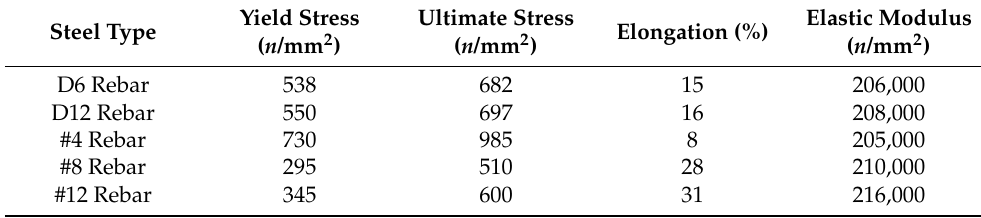
Table 2. Mechanical properties of steel rebars of HPLW and LW